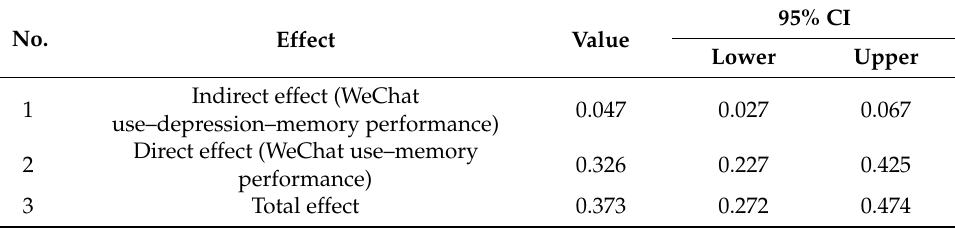
Table 5. Indirect, direct, and total effects and 95% confidence intervals (CI) for the mediation